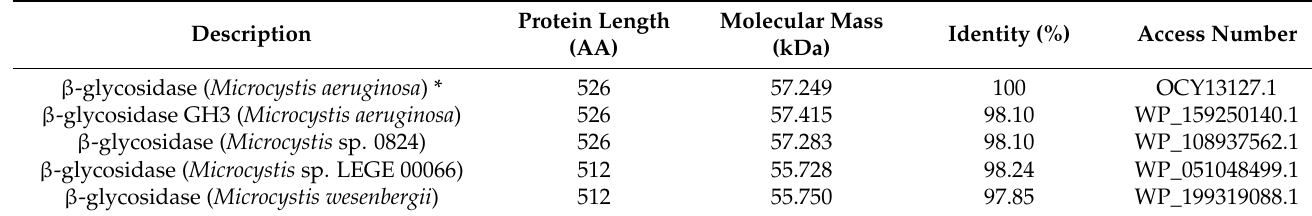
Table 1. BLASTp result for